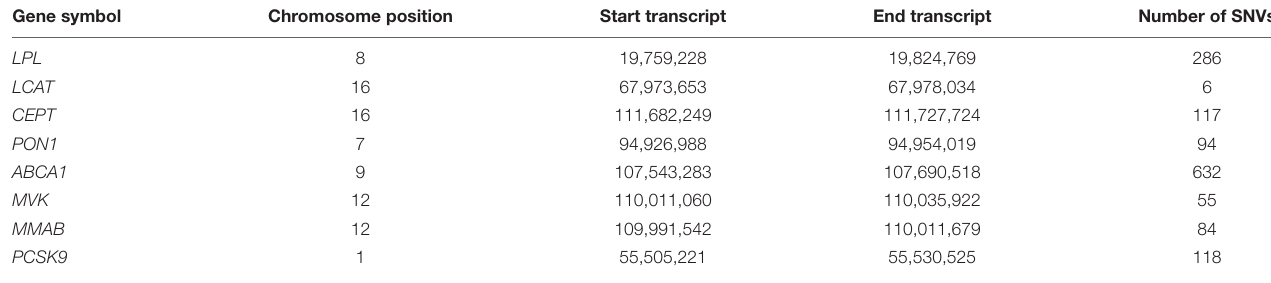
TABLE 1 | Number of variants tested within selected genes following quality control of